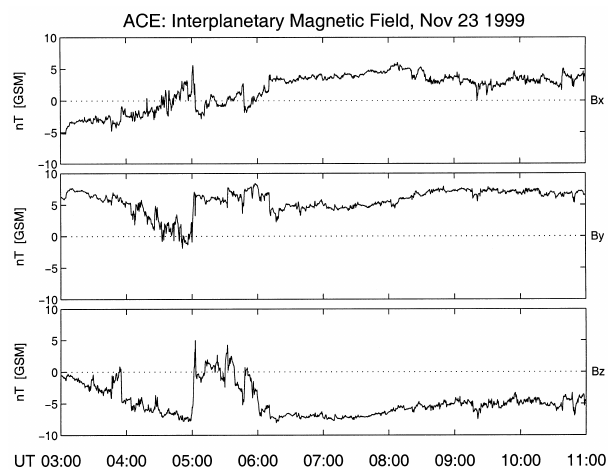
Fig. 1. The GSM components of the interplanetary magnetic field (IMF) measured by the ACE spacecraft near the first Lagrange point from 03:00–11:00 UT on 23 November